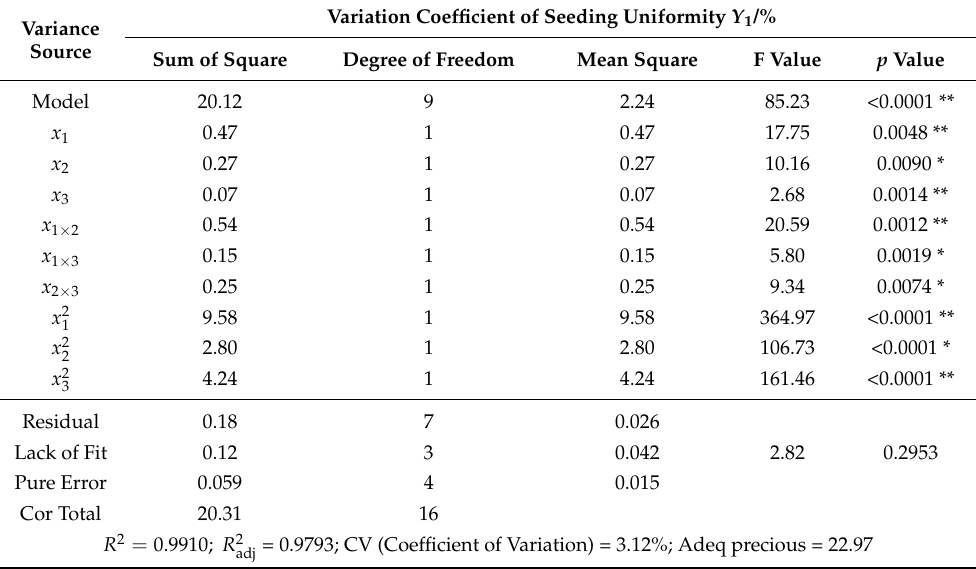
Table 4. Variation coefficient of seeding uniformity analysis results. Variation Coefficient of Seeding Uniformity Y 1 /% Variance Source Sum of Square Degree of Freedom Mean Square F